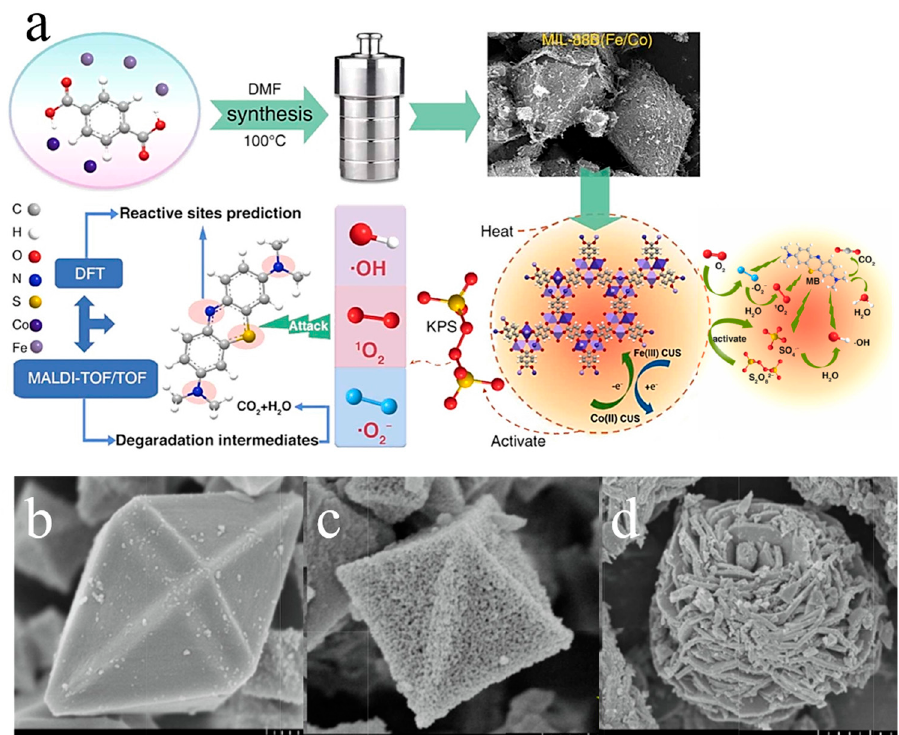
Figure 13. ( a ) Synthesis process of MIL-88B (Fe/Co) and heterogeneous activation mechanism of PDS. Adapted with permission from Ref. [82], 2023, Elsevier. ( b ) SEM images of FeCo/N-MOF, ( c ) Fe/N-MOF, and ( d ) Co/N-MOF. Adapted with permission from Ref. [83], 2023, Elsevier.